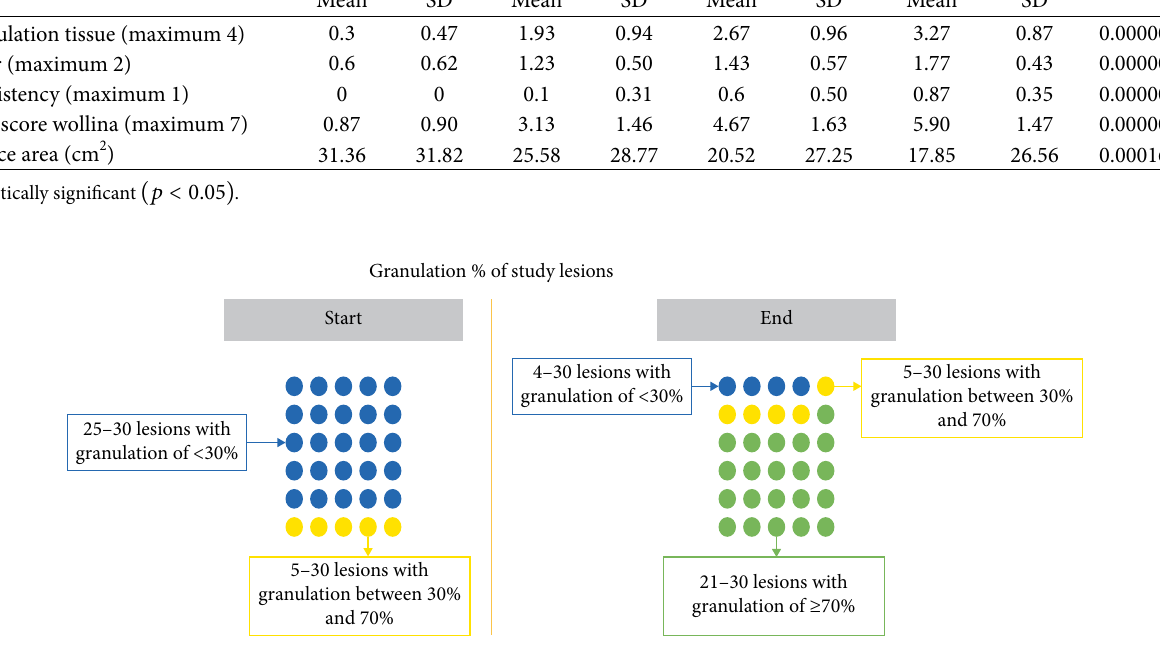
Figure 6: Results obtained with the use of PolyHeal ® Micro: granulation.